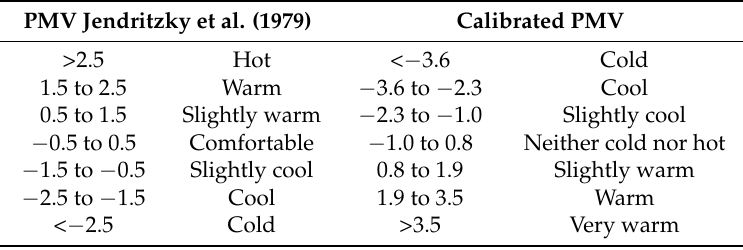
Table 2. Cutoff points for classes corresponding to variable Response to Question 1 (*) of the questionnaire, calibrated for